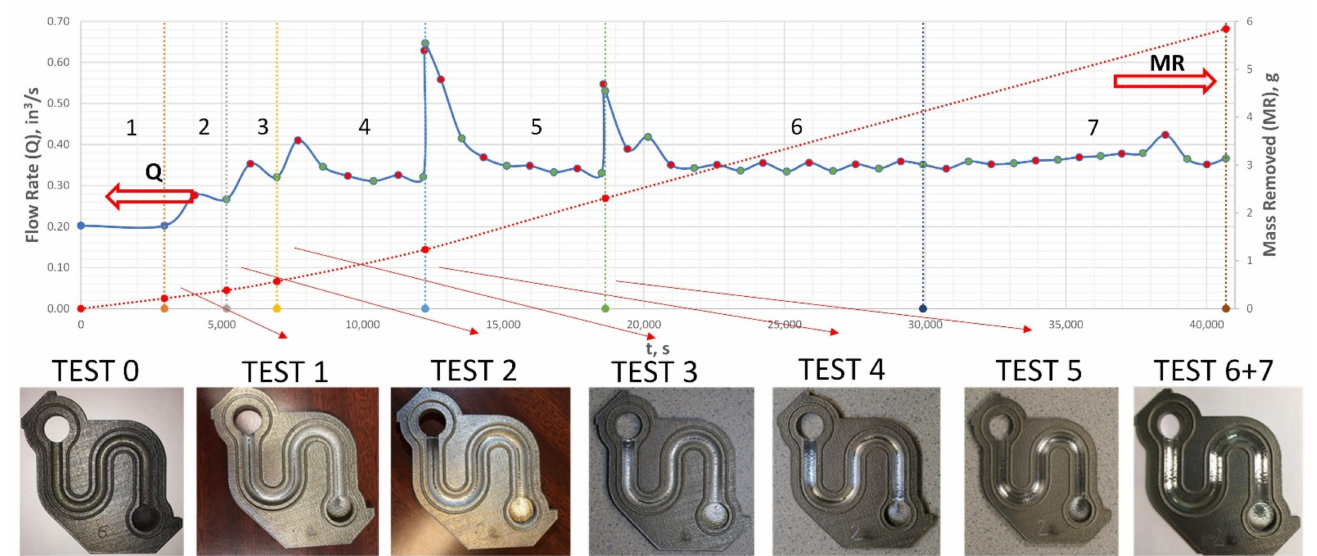
Figure 19. S-shape specimens detailed AFM analysis as a function of polishing